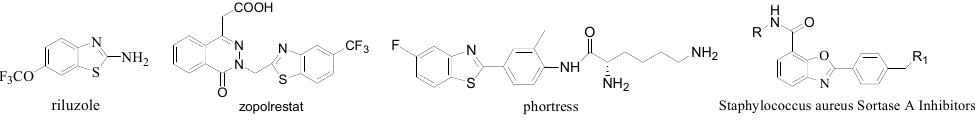
Figure 1. Biologically active benzoxazole and benzothiazole